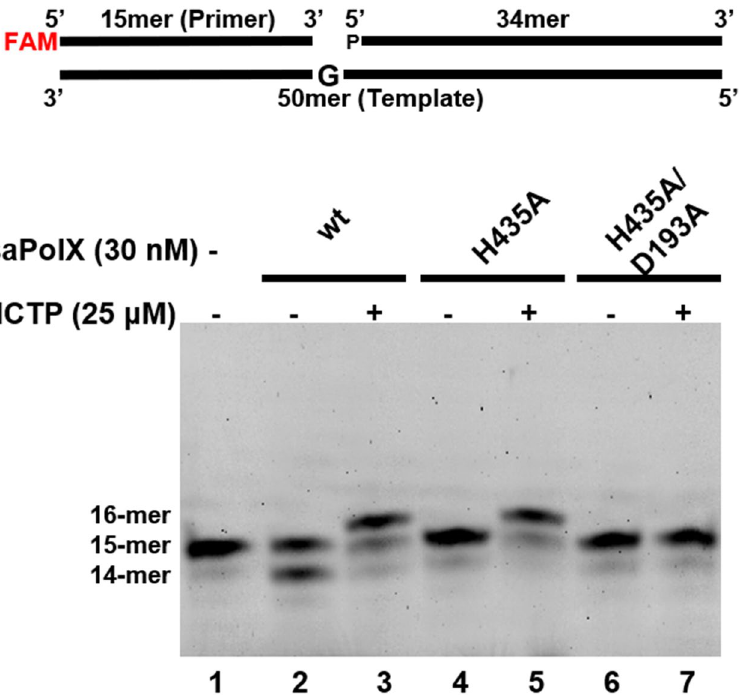
Figure 4. Enzyme activities of wt-saPolX, mutant H435A and double mutant H435A + D193A. Primer extension assays were performed on a gapped DNA substrate to check the polymerase and exonuclease activities present in wt-saPolX and exonuclease mutant H435A. The results show that wt-saPolX possesses both polymerase and exonuclease activities. The mutation H435A abolished the exonuclease activity of saPolX and the mutation D193A removed the polymerase